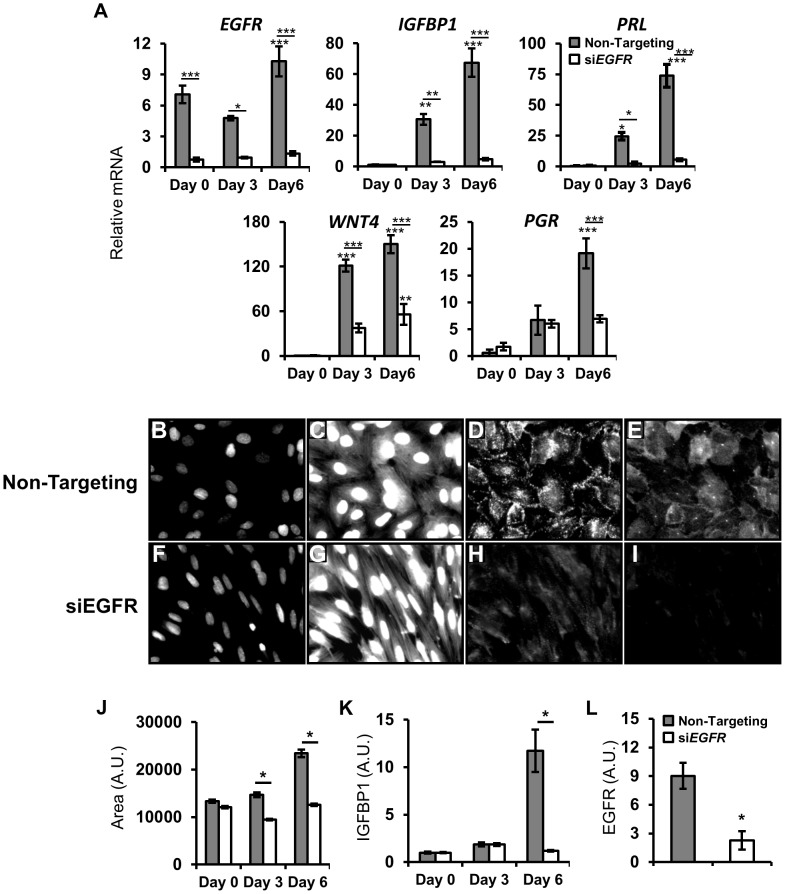

EGFR attenuation inhibits human endometrial stromal cell (HESC) decidualization.HESC were transfected with non-targeting or EGFR siRNA. After 48 h, HESC were treated with deciduogenic hormones and assessed at day 0, day 3 and day 6. (A) qPCR analysis of known decidual markers and regulators. (B–L) Day 6 automated quantitative image-based analysis of the effects of siEGFR on decidualization. (B–I) Immunofluorescent images of HESC transfected with (B–E) non-targeting siRNA or (F–I) EGFR siRNA after 6 days of deciduogenic hormones. (B,F) DAPI staining of nuclei (470 nm, low exposure). (C,G) Staining of cell surfaces with CellMask Blue stain (470 nm, high exposure). (D,H) Immunolableing of decidual marker IGFBP1. (E,I) EGFR immunolabeling. (J–L) Quantification of siEGFR and decidual changes. (J) Measurement of cell size. (K) Induction of IGFBP1 expression. (L) Day 6 expression levels of EGFR. Average +/− SEM. *-p<0.05; **-p<0.01; ***-p<0.001.